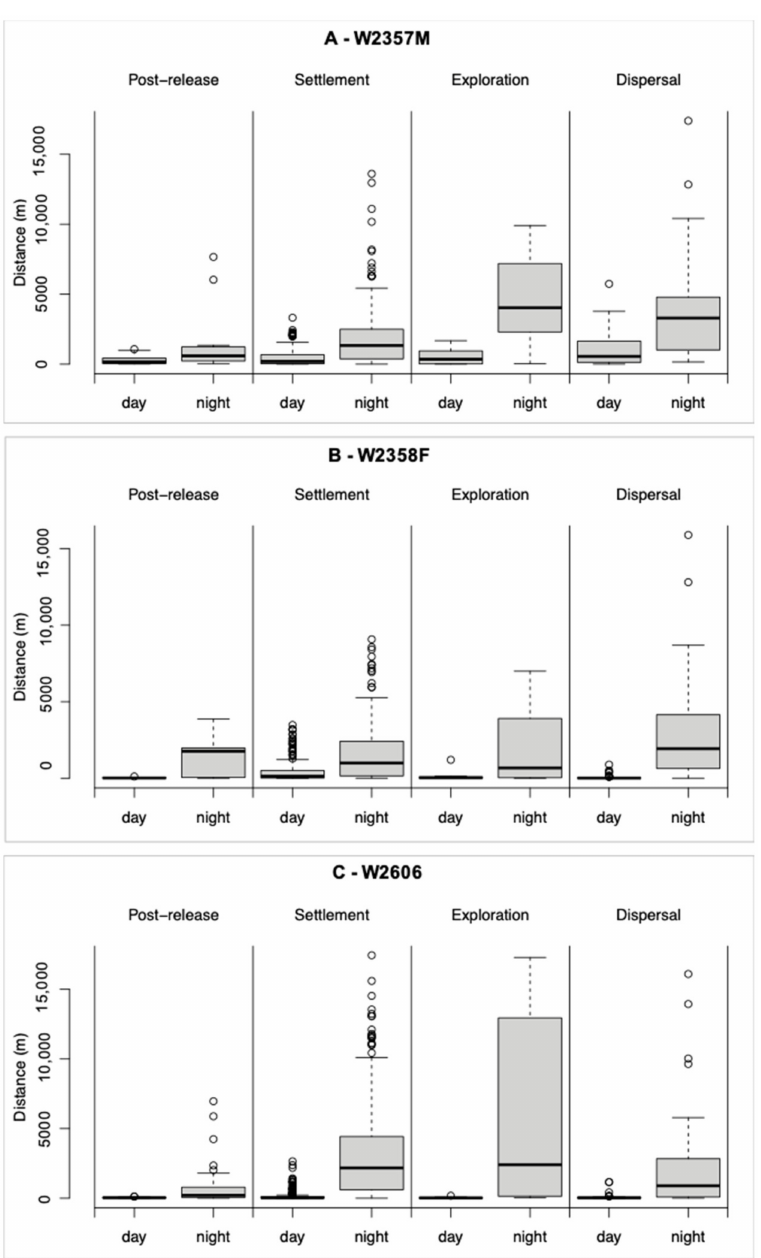
Figure 4. Diurnal and nocturnal step lengths for each movement pattern of three GPS-collared wolves in Northern Italy, 2019–2021. ( A ) W2357M; ( B ) W2358F; ( C )